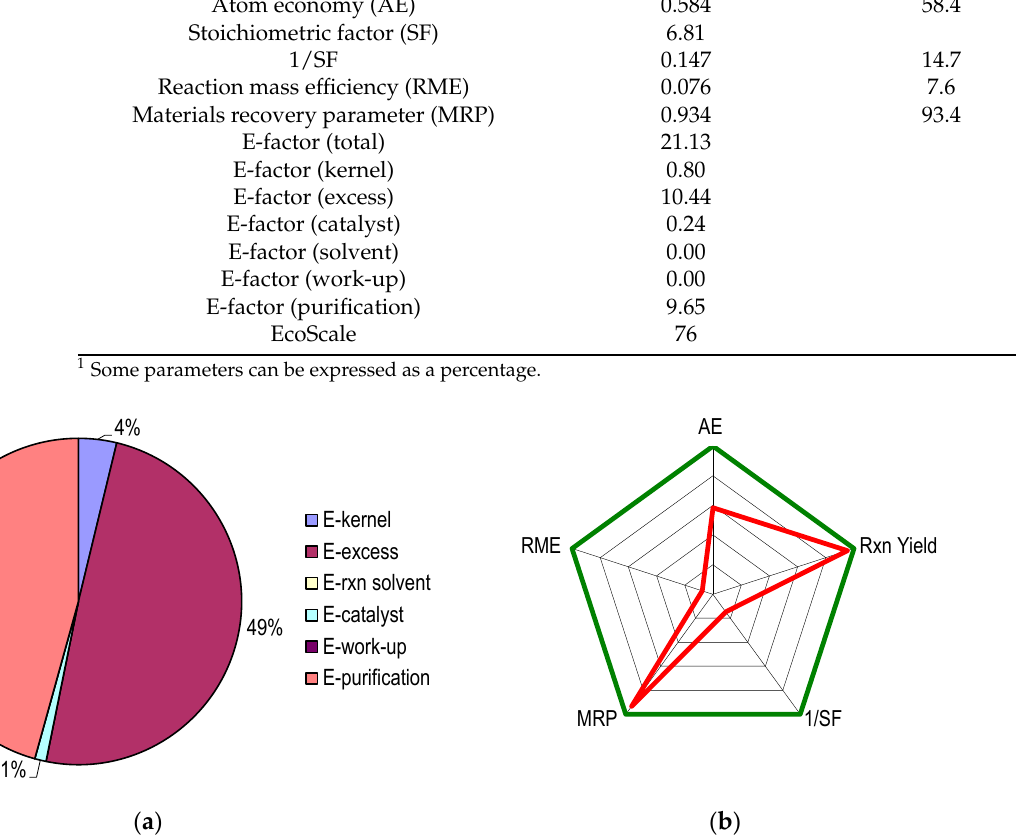
Table 1. Green metrics for the synthesis of DEET by oxidative coupling catalyzed with bcmim-Cu . Parameter Reaction yield (Rxn yield)